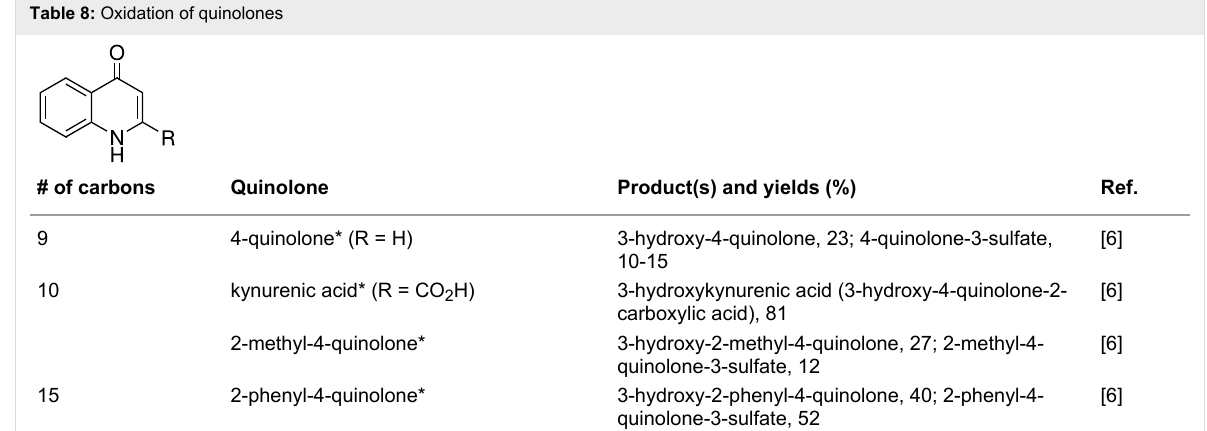
# of carbons Quinolone Product(s) and yields (%)